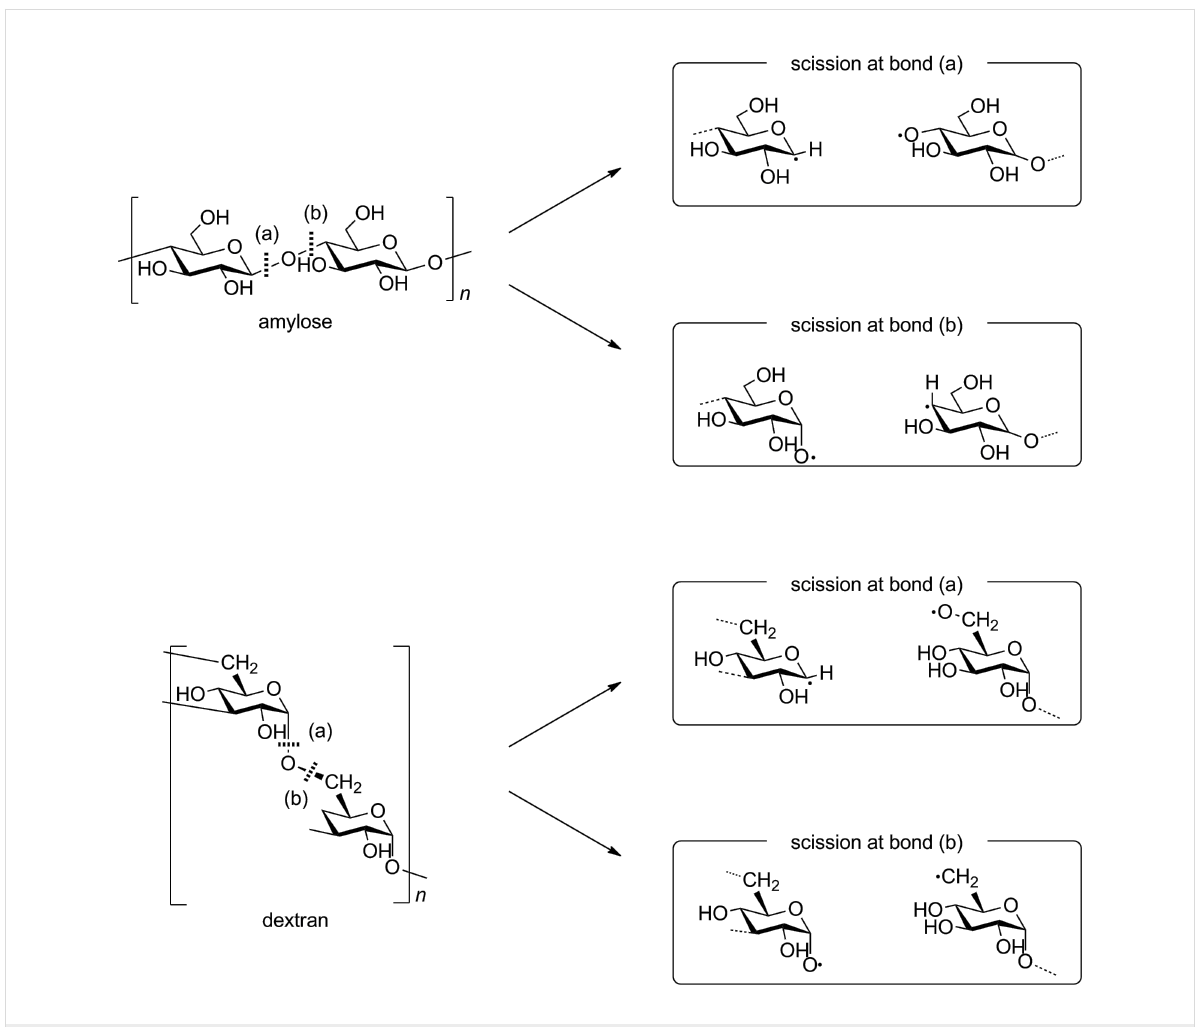
Figure 4: Schematic representation of bond cleavage at α -1,4- and α